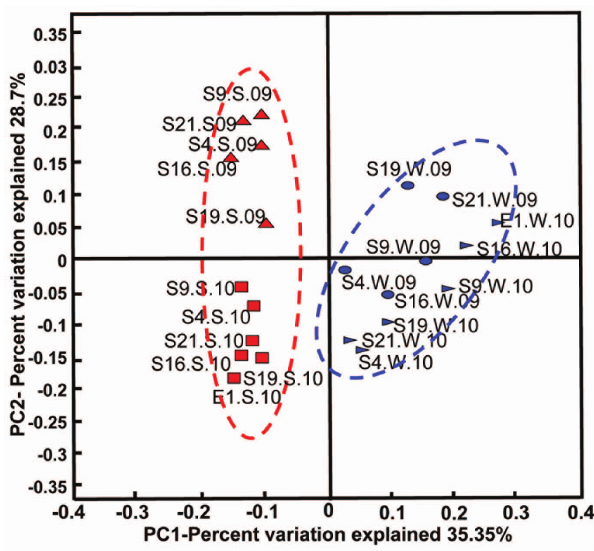
Figure 3. Similarity of microbial communities from the surface sediment and overlying bottom water from the PRE, as illustrated by the UniFrac distance-based PCoA plot. See Table 1 and Figure 2 for the sample identifiers. Ellipses indicate 95% of confidence interval.